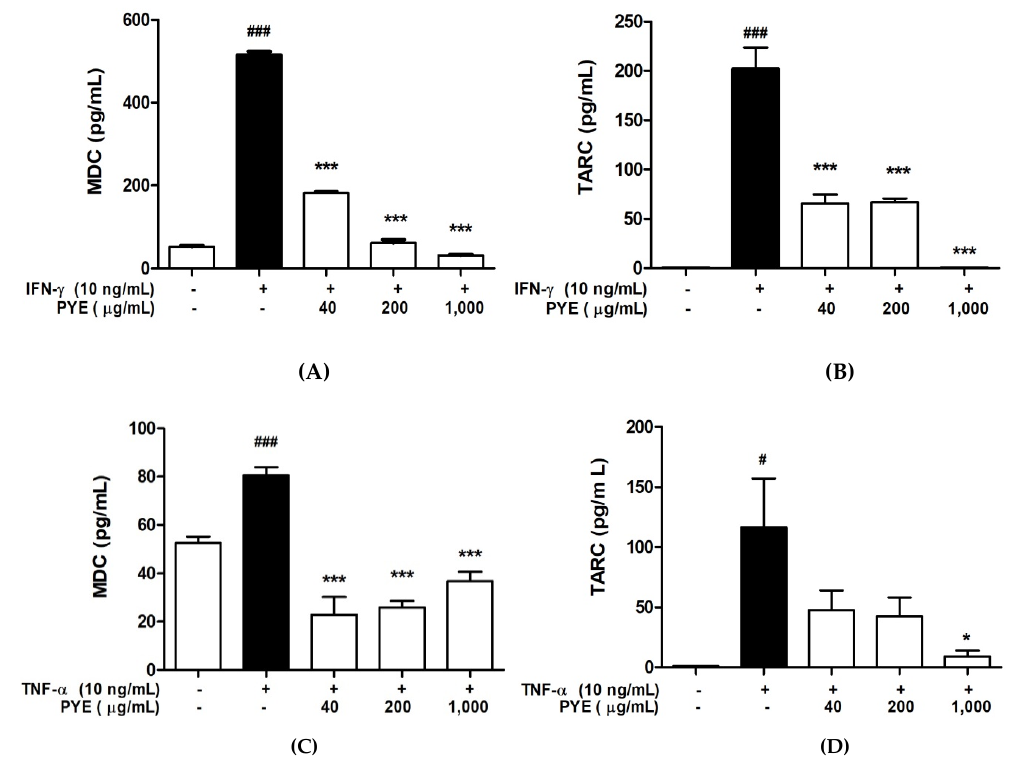
Figure 3. E ff ects of PYE on the TNF- α / IFN- γ -induced production of chemokines in HaCaT cells. The cells were treated with IFN- γ ( A , B ) or TNF- α ( C , D ) (10 ng / mL) in the absence or presence of varying concentrations of PYE for 24 h. After treatment, cell supernatants were measured by ELISA. Data are presented as means ± standard deviation (SD) of triplicate experiments conducted in duplicate. Note: ### p < 0.001 and # p < 0.01 control group vs. the IFN- γ or TNF- α (10 ng / mL)-treated group, and * p < 0.05 and *** p < 0.001 IFN- γ or TNF- α (10 ng / mL)-treated group vs. PYE co-treated